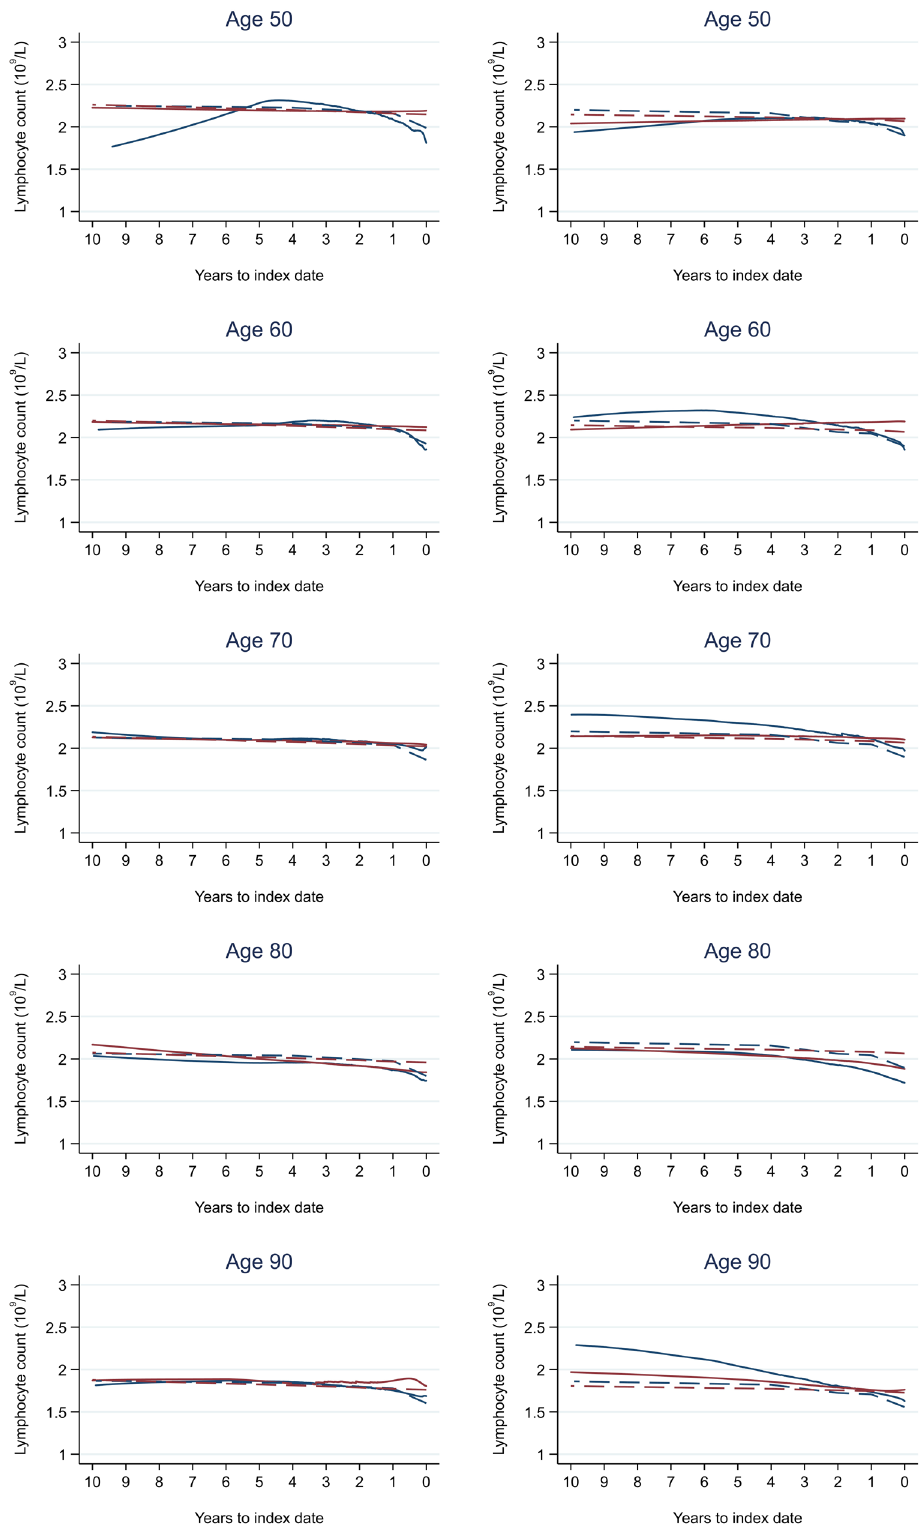
Figure 15. Lymphocyte trends between cases and controls, by age at index date 1,2 . 1 Index date was the date of diagnosis for cases and a randomly selected date in the patient’s study period for controls. 2 LOWESS trends are age (+/- 3 years) and modelled (fixed effects) trends are taken at that specific age. Legend: males (left) and females (right). Colorectal cancer (blue line) and no cancer (red line). LOWESS trend (solid line) and modelled trend (dashed line).